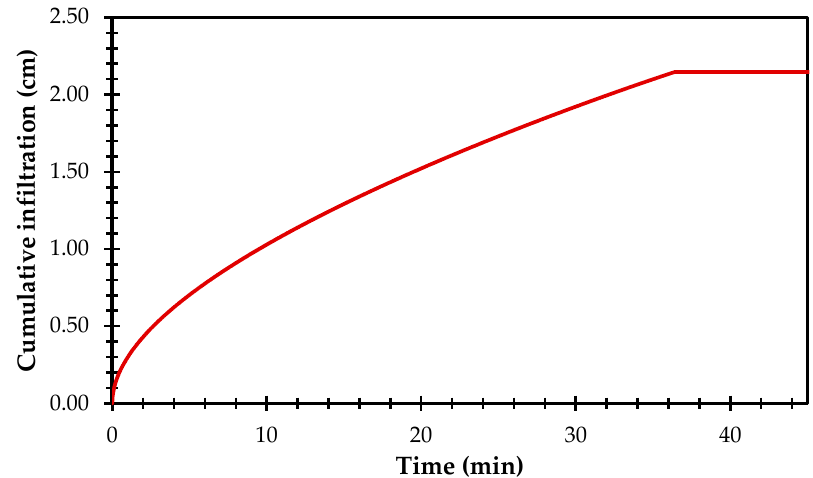
Figure 6. Evolution of the infiltrated depth in a border irrigation with a shallow water table.